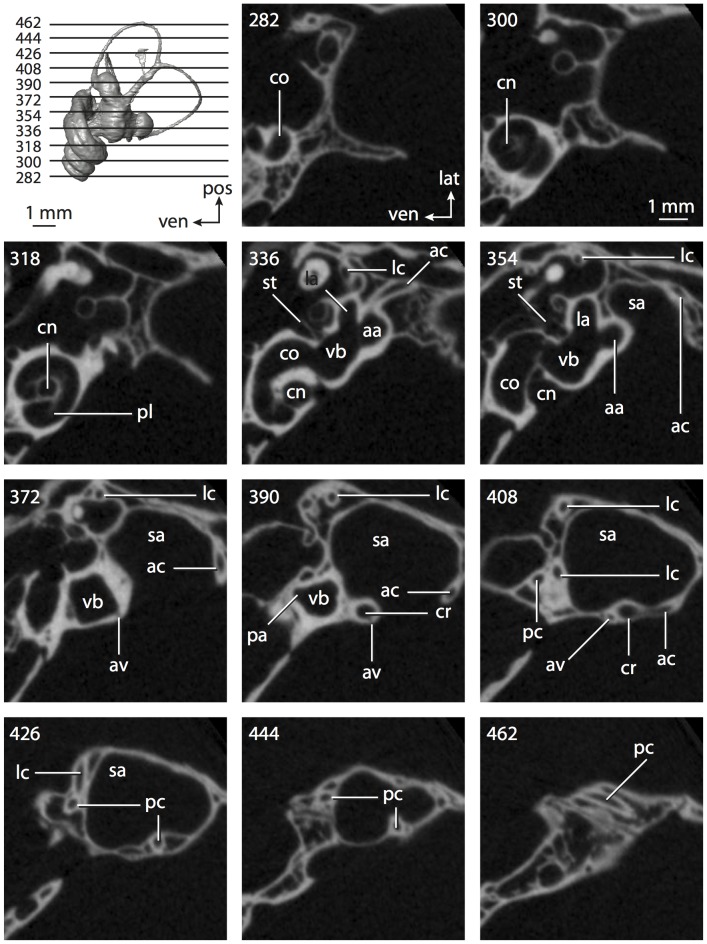
CT slices through ear region ofTupaia glis.
Abbreviations listed at the end of the Materials and Methods section.